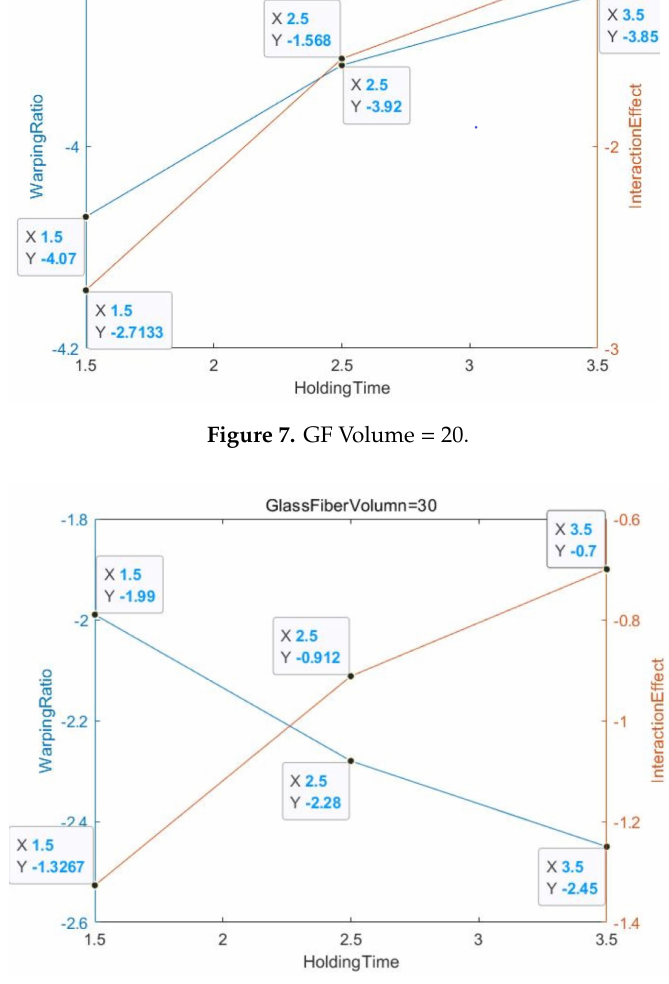
Figure 8. GF Volume = 30.